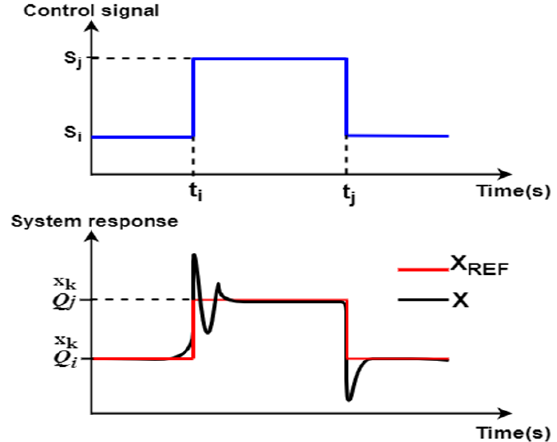
Figure 1. Classical abrupt switching.